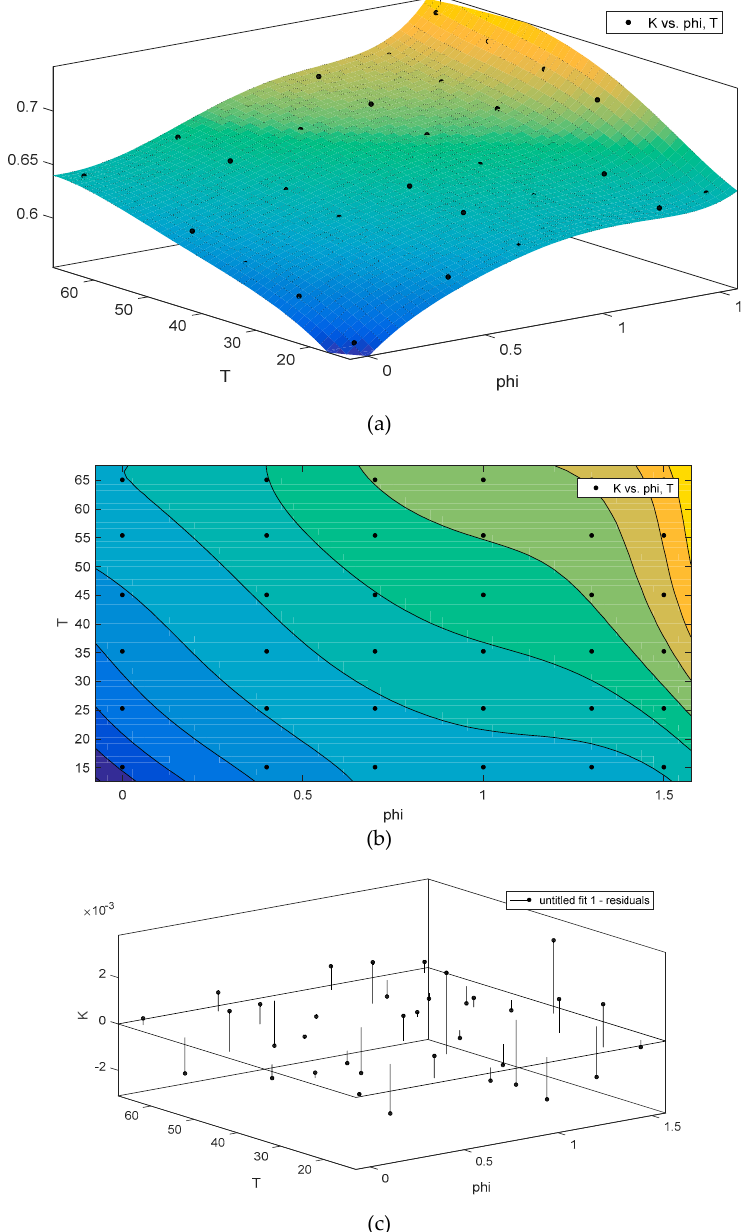
Figure 6. ( a ) Contour plots, ( b ) 3D, and ( c ) proposed model for the thermal conductivity coefficient (Temperature is in °C and phi (Volumetric Concentration (%)).